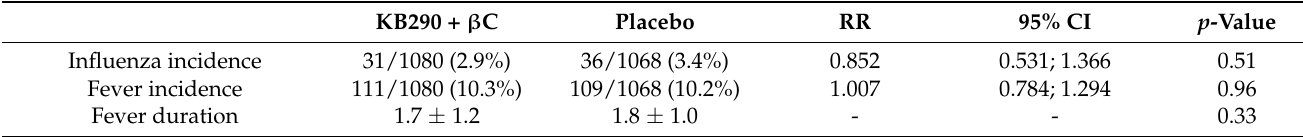
Table 2. Influenza incidence, fever incidence, and fever duration 1